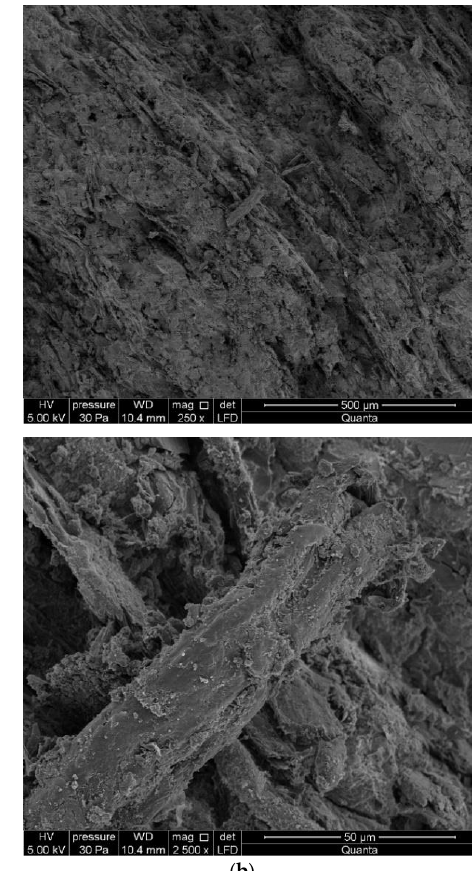
Figure 6. The microscopic observations of the applied fibres, in scanning electron microscope (SEM) with scale bar in sequence 1 mm, 500 µm and 50 µm: ( a ) air-dry condition (reference board), ( b ) board exposure to temperature of 230 ◦ C-3 h.